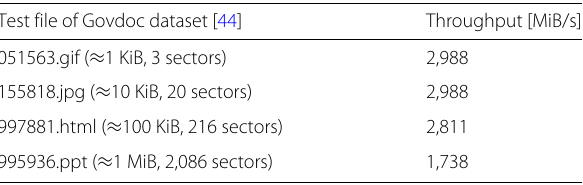
Table 6 Average query throughput of Algorithm 4 without random sampling